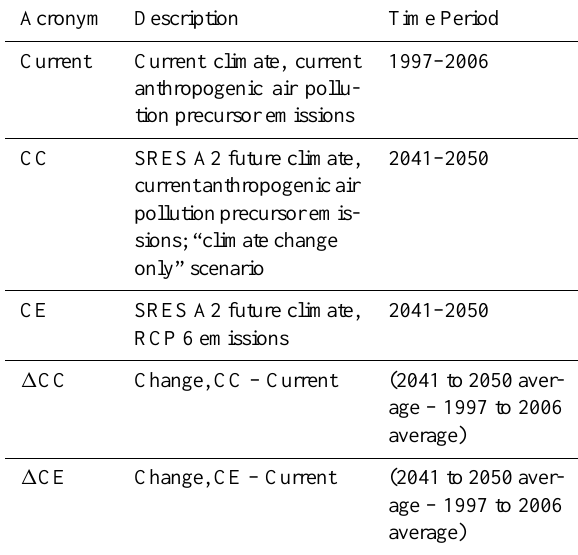
Table 1. Acronyms for model scenarios and calculated differences between